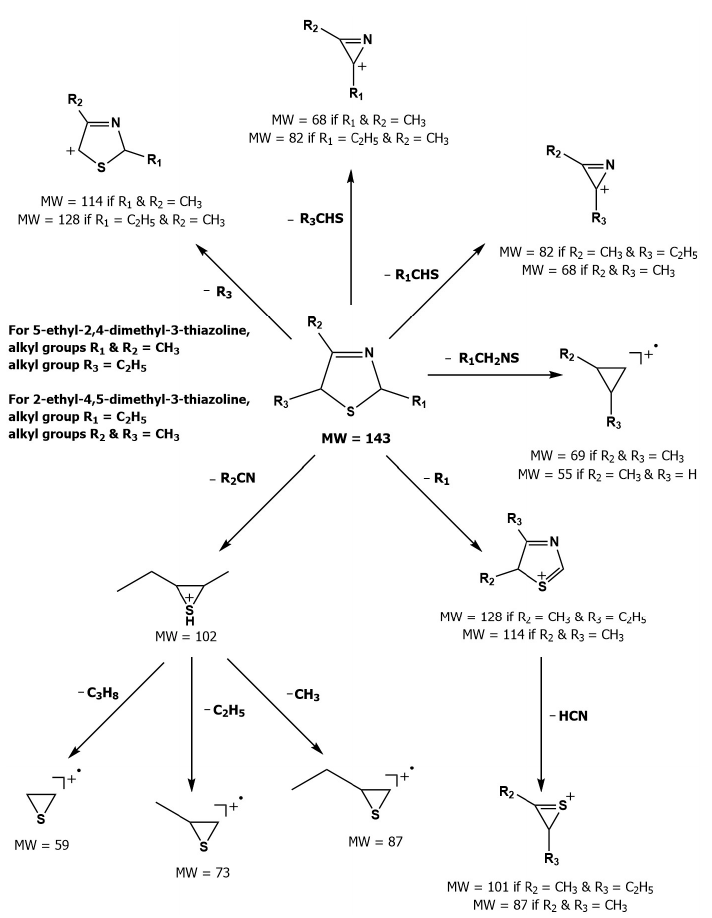
Figure 3. Mass fragmentation pattern of 5-ethyl-2,4-dimethyl-3-thiazoline and 2-ethyl-4,5-dimethyl- 3-thiazoline (Adapted with permission from Elmore et al. [53] and Bredie et al. [54]. Copyright 1997 and 2002 American Chemical